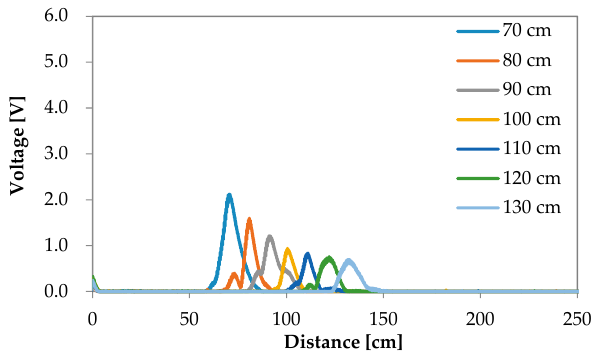
Figure 9. Experimental results of the reflection wave with respect to lawn.